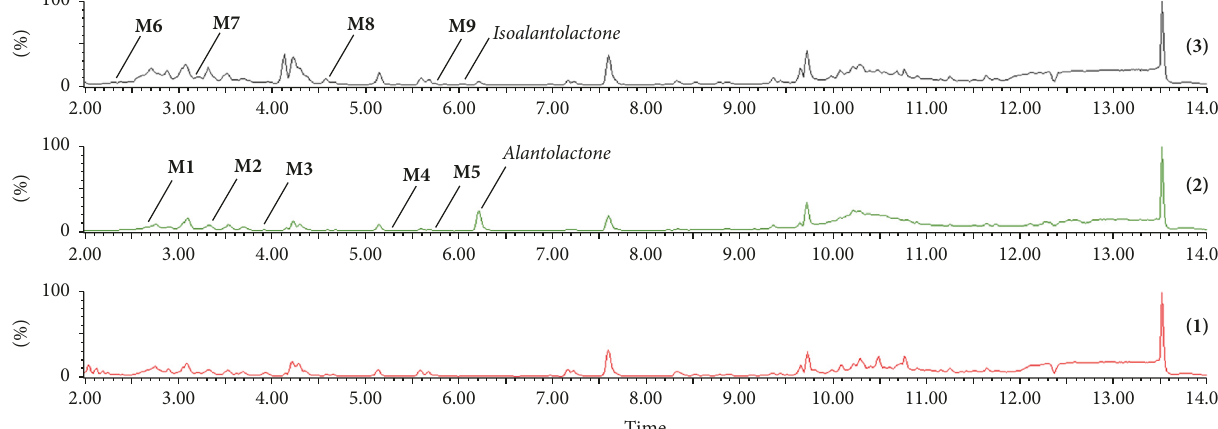
Figure 1: Representative TIC chromatograms of bile collected during 24 h after oral administration of alantolactone and isoalantolactone. (1) Blank group; (2) alantolactone group; and (3) isoalantolactone